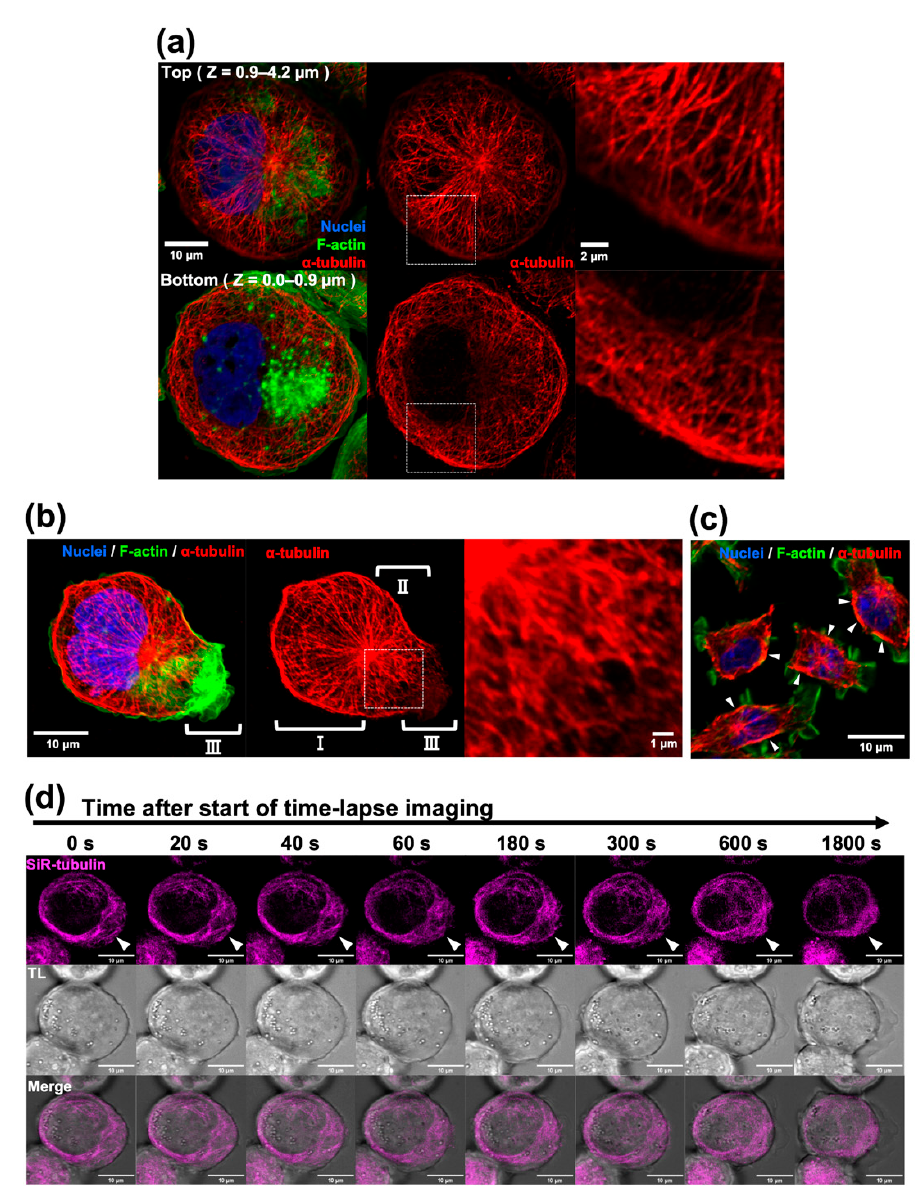
Figure 1. Microtubule staining of THP-1-derived macrophages. ( a ) Resting stage macrophages were fixed with a new protocol and immunostained with an anti- α -tubulin antibody (red), phalloidin (green), and DAPI (blue). Confocal optical sections of the upper half (Z = 0.9–4.2 µm) and lower half (Z = 0.0–0.9 µm) were stacked. The merged image (left), tubulin-single channel (middle), and enlarged image of the white boxed region (right) are shown. ( b ) The resting-but-somewhat-active macrophage was stained. The merged image (left), tubulin-single channel (middle), and enlarged image of the white boxed region (right) are indicated. The regions where the radial microtubules were evident ( I ), the pseudopod was protruded ( II ), and membrane ruffling was evident ( III ) are distinguished. ( c ) RAW-264.7 mouse macrophages were stained with an anti- α -tubulin antibody (red), phalloidin (green), and DAPI (blue). A single optical section of the merged image is shown. Arrowheads indicate that thick microtubule bundles covered microtubule-rich cytoplasm near